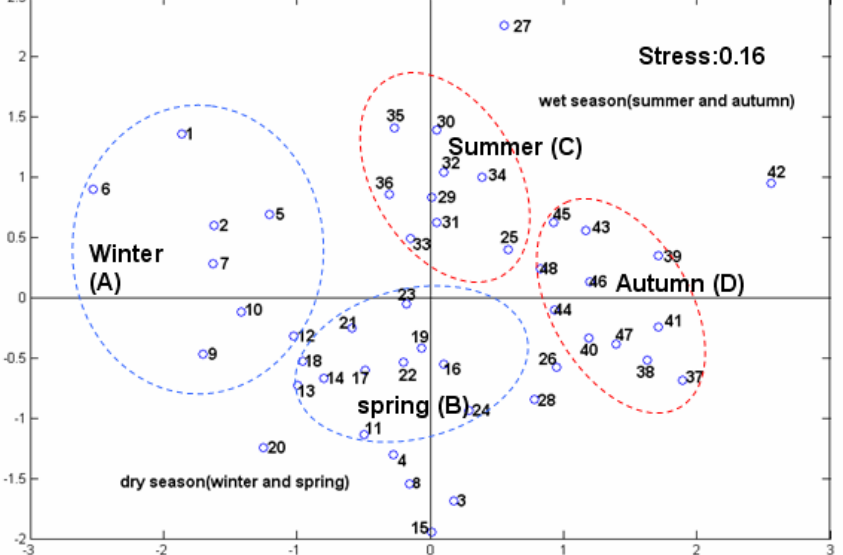
Figure 7. NMDS of phytoplankton community structure (numbers from 1 to 12 represent winter stations 1–12; numbers from 13 to 24 represents spring stations 1 to 12; numbers from 25 to 36 represent summer stations from 1 to 12; numbers from 37 to 48 represent autumn stations from 1 to